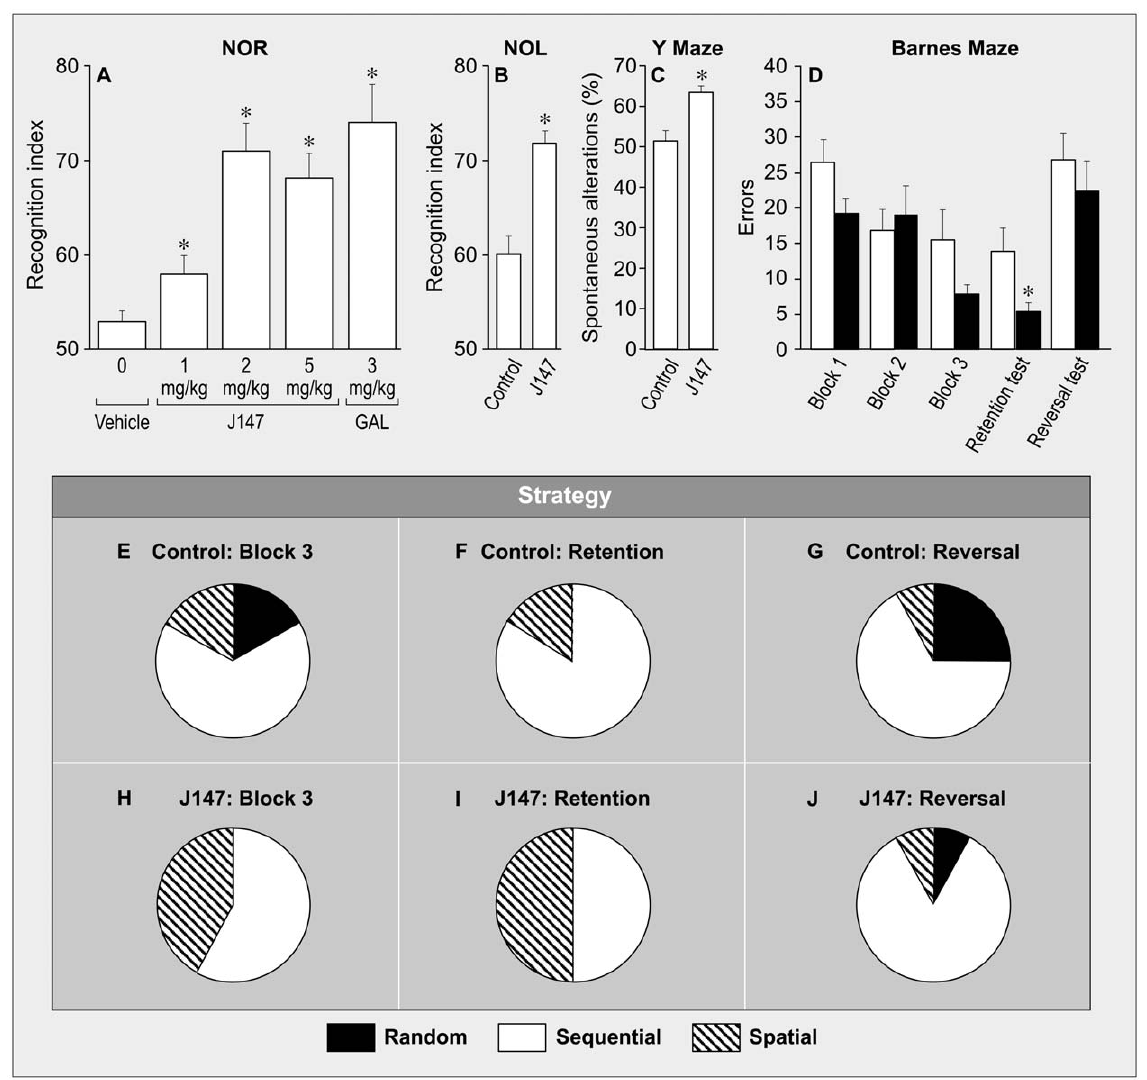
Figure 4. Behavioral Assays. (A) The novel object recognition test (NOR) was employed for compound J147. Doses of 1, 2 and 5 mg/kg were administered by oral gavage to 7 wk old Sprague-Dawley rats 1 hr prior to training. Treatment with J147 increased the recognition index with all three concentrations. Galantamine, injected IP at 3 mg/kg, served as a positive control, one-way ANOVA F (3, 40)=12.9. * P , 0.05 n=12 per group (Done by Behavioral Pharma, La Jolla, CA). In panels B-J normal male C57BL/6J mice were fed J147 at 200 ppm for 2 wks and the Barnes maze assay was then done, which required 8 weeks to complete. This was followed by the novel object location (NOL) and Y-maze assays. (B) Novel object location (NOL) assay; the assay was performed similarly to (A) except that one object was used and it was moved to a new location instead of being replaced by another. J147 treated mice had significantly greater recognition indexes than control mice in this assay (n=12 per group: one-way ANOVA F(1,22)=2.5, *P , 0.05). (C) Y-maze. The tendency of rodents to sequentially explore 3 arms of the Y-maze is a measure of short-term memory. While the groups did not differ in total arm entries, mice fed J147 exhibited a higher percentage sequential entries into all 3 arms (spontaneous alterations). F(1,22)=3.3 p=0.0032. (D) The error rate in the acquisition phase of the Barnes maze, 9 consecutive days, pooled data from 3 days per block. A lower error rate indicates better learning. The difference between control (white bar) and J147-fed mice (black bar) in Blocks 1 and 3 are almost significant (n=12 per group: one-way ANOVA F(1,22)=2 and F(1,22)=1.8, respectively, P . 0.05 for both). Six weeks after the final acquisition phase, mice were re-assayed and J147 significantly improved memory (retention test) (n=12 per group: one-way ANOVA F(1,22)=2.6, * P , 0.01) but had no effect when the escape tunnel was relocated (reversal test). (E–J) The strategy used by the mice to find the escape tunnel was determined from videotapes and mice fed J147 tended to use a spatial strategy rather than sequential or random ones (z=2.33, P =0.019 for Block 3; z=1.73, P =0.80 for retention). All data shown are means 6